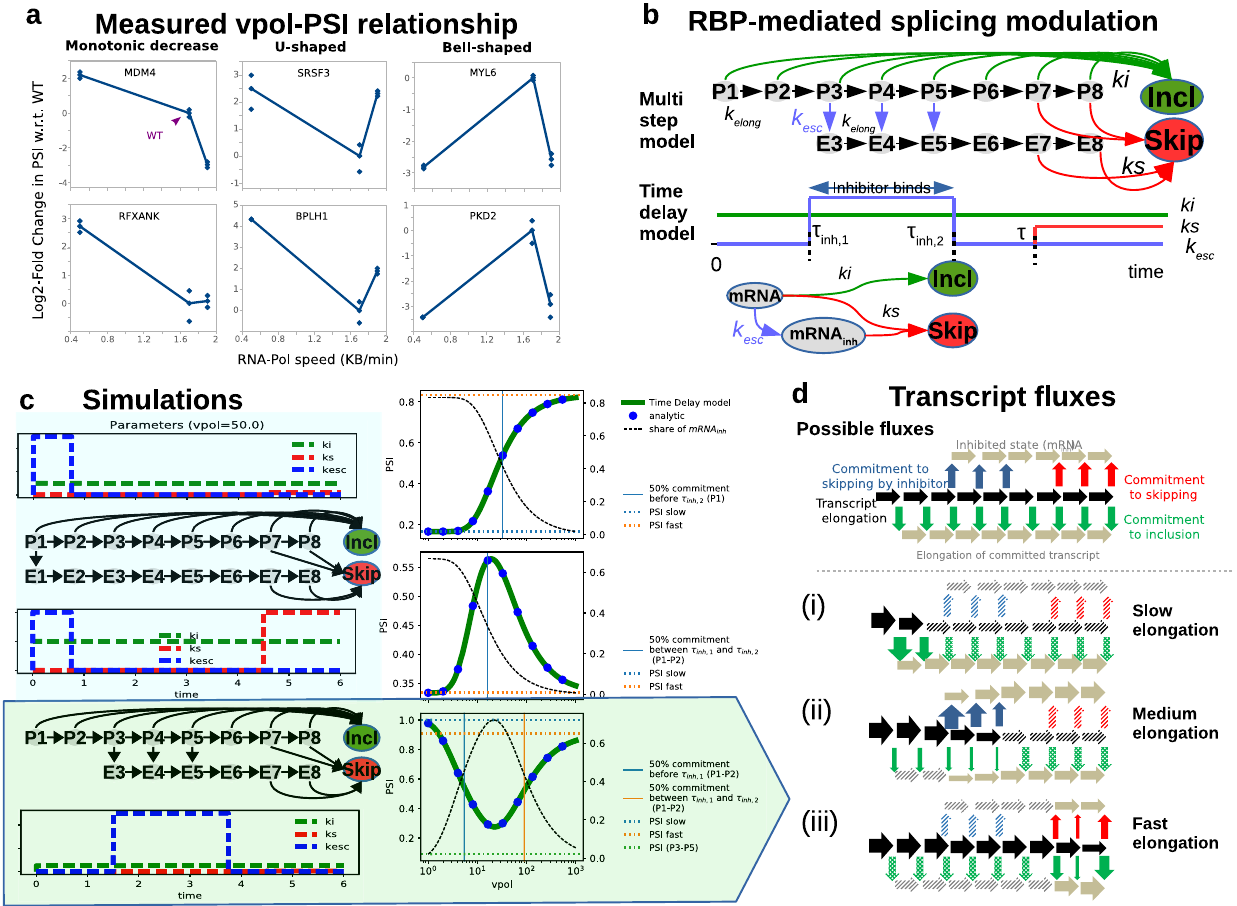
Fig. 2 Complex PSI-vpol pro fi les with RBP-mediated splicing inhibition. a Experimentally measured relationship between polymerase speed (vpol) and splicing outcomes (PSI) taken from Figs. 2, 3, and 4, and supplemental Figs. 3, 4, and 5 of Fong et al. 31 . Splicing pro fi les of selected splicing events (indicated in titles) as assessed by PCR and gel electrophoresis are shown for polymerase mutants with enhanced and lowered transcript elongation rate (left and right datapoints), alongside pro fi les when cells express the wildtype enzyme (middle datapoints). Each datapoint is one out of three replicate measurements. The PSI metric can increase or decrease with polymerase speed, and may show U- or bell-shaped responses. b Co-transcriptional splicing commitment model with RBP-mediated inhibition of exon inclusion. Top: Multistep model with inhibitor-mediated escape from inclusion ( k esc ) towards skipping-committed pre-mRNA molecules (species E3-E8). The depicted model topology involves two steps before inhibition/escape reaction (P1-P2), a window of opportunity for inhibition (P3-P5), a late state (P6) where skipping is not possible (exon 3 not synthesized) and stages where both inclusion and skipping reactions are possible (P7-P8). Bottom: The time delay model with RBP-mediated inhibition derived from the topology in Fig. 1c. Compared to the basic model it contains an additional species mRNA inh representing an RBP-inhibited mRNA . Also there are two additional time delays τ inh,1 , τ inh,2 marking the window of opportunity for inhibition. c Simulated PSI-vpol pro fi les with RBP-mediated inhibition. Top and middle: Early inhibition scenario, where RBP- mediated inhibition ( k esc ) occurs already before/when exon 2 is synthesized (reaction P1 → E1 in multistep model). Monotonically increasing or bell-shaped PSI-vpol pro fi les are observed, depending inclusion-to-skipping (ki/ks) ratio towards the end of the transcript (red dashed lines in PSI-vpol diagram). Bottom: Late inhibition scenario, in which the RBP-mediated inhibition (kesc) occurs after synthesis of exon 2 (reactions P3 → E3, P4 → E4 and P5 → E5 in multistep model), can result in a U-shaped PSI-vpol pro fi le. The black solid lines depict the fraction of mRNA being inhibited during transcription (i.e., progressing through the mRNA inh state in the delay model). This fraction decreases since fast elongation diminishes the window-of-opportunity for RBP binding. Horizontal lines indicate approximate splicing outcomes predicted by the ratio ki i /(k s + k esc ) in different splicing commitment regimes along the transcript. As discussed in panel d , at slow and fast elongation, splicing decisions are made early and late after transcript initiation, respectively. Therefore, PSI slow, fast and P3 → P5 indicate inclusion-to-skipping ratios at early, late and intermediate times in transcript lifetime. Vertical lines depict the value of vpol at which 50% splicing commitment occurs in these regimes along the transcript. d Schematic representation of transcript fl uxes at different elongation rates for the late inhibition scenario (bottom panel in c ). On the top all possible fl uxes for one mRNA molecule are depicted. The lower part shows the main reaction fl ux considering three elongation regimes. The solid arrows show the main reaction fl ux, the shaded arrows typify minor or not existing fl As depicted in Fig. 3a (right), the inhibitory RBP modulates reactions (k spl ) lead to inclusion (state P111), skipping (P101) or splicing outcomes by irreversibly binding to all unspliced pre- retention (all other states). The resulting mathematical model is a mRNA states (e.g., P000 → P000_inh) with the rate rbp_br . limit case of the more general kinetic model introduced in Subsequently, spliceosome binding occurs at reduced rates Enculescu et al. 46 if we assume irreversible spliceosome binding to (k1_inh-k3_inh), but splicing rates (k spl ) remain unchanged. Thus, the pre-mRNA. However, in contrast to the previous work 46 , we additionally considered here dynamic changes in splicing out- the inhibitory RBP changes splicing outcomes by blocking initial comes due to RBP inhibitor binding and co-transcriptional splicing spliceosome recruitment. Importantly, this occurs only locally dynamics. around the sites of RBP binding, i.e., around an assumed RBP